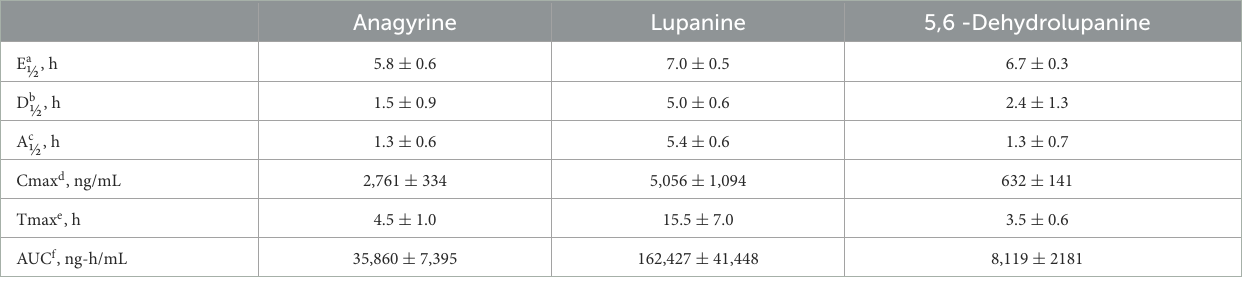
TABLE 2 Serum toxicokinetic parameters of three alkaloids from L. leucophyllus orally dosed (2.5g dried, ground plant material per kg body weight) to Holstein steers